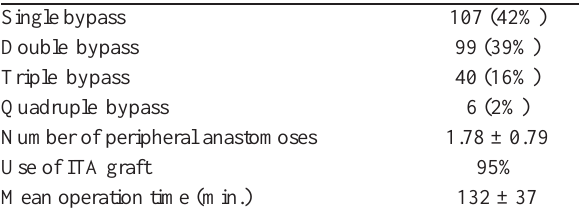
Table 2. Intraoperative data.